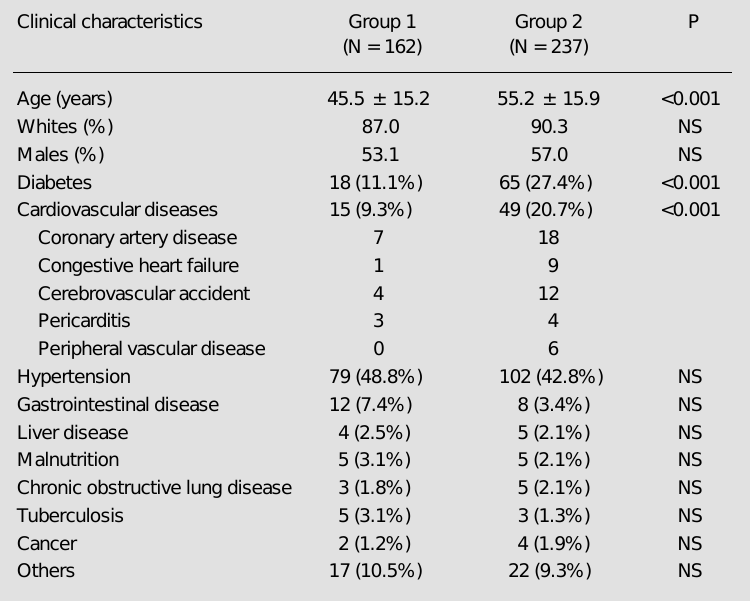
Table 2 - Number of patients at risk per year of observation and crude annual death